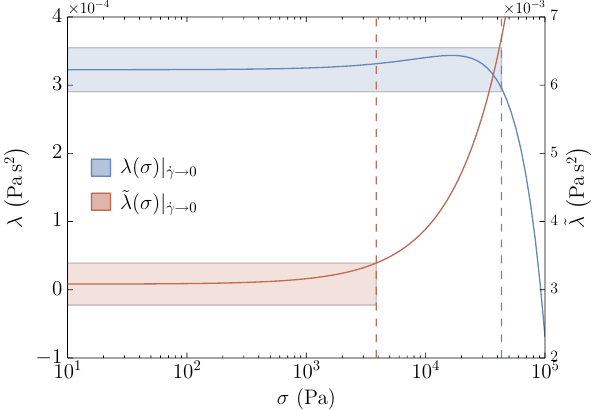
Figure 8. The factors λ (blue) and e λ (red) for ˙ γ → 0. The colored areas show ranges of σ where the respective value can be approxi- mated with the value at σ → 0 within an error of ± 10%. λ remains in the range of λ | σ → 0 ± 10% up to 4 × 10 4 Pa, e λ in the range of e λ | σ → 0 ± 10% up to 4 × 10 3 Pa.